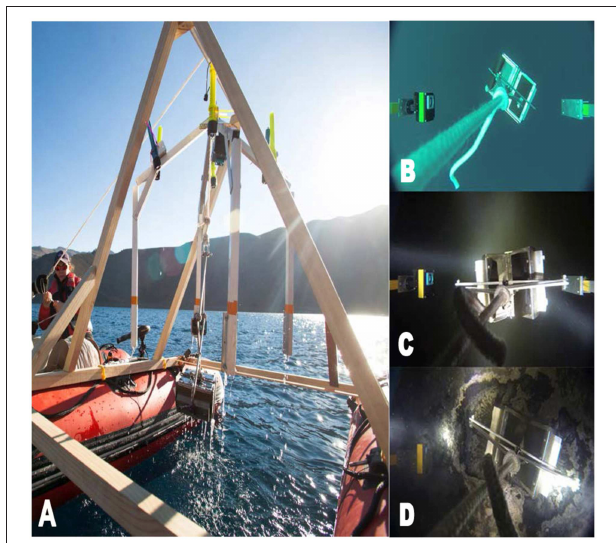
FIGURE 5 | (A) sampling system using two zodiac boats and intervening winch for the collection of sediments, enabling a targeted Rapid Environmental Assessment (REA) based on imagery by means of a GoPro 300 system within a 300-m depth rated casing attached to gear (B) and sampling of sediments with a sampling grab (C) . The grab makes contact with the lakebed at Kraken Dive (272m depth) (D)